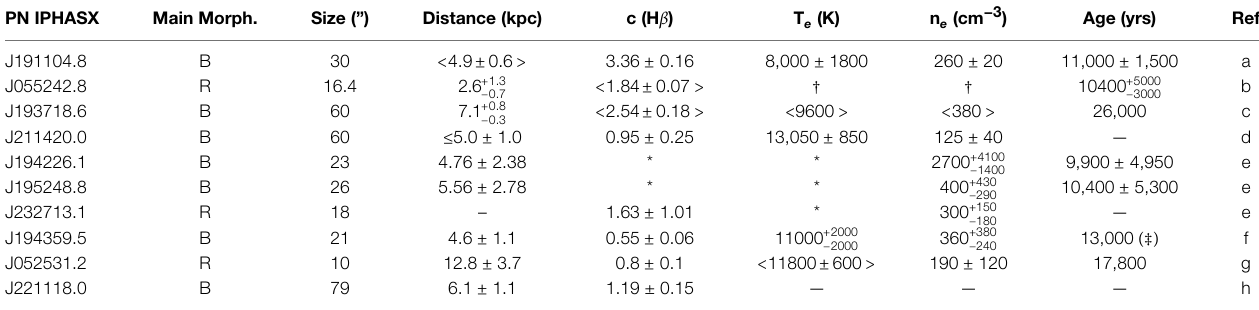
TABLE 1 | Optical physical parameters reported for the group of 10 IPHAS PNe. PN IPHASX Main Morph. Size